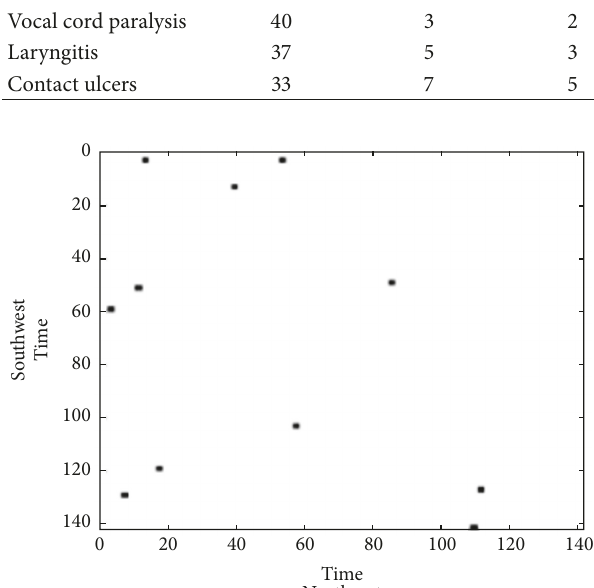
Figure 13: CRP for the regions in China: Southwest and Northeast.